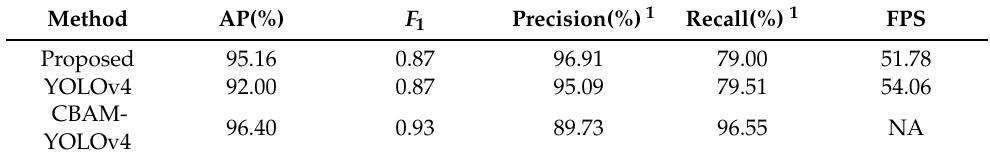
Table 1. Performance evaluation result comparison on HRED dataset.